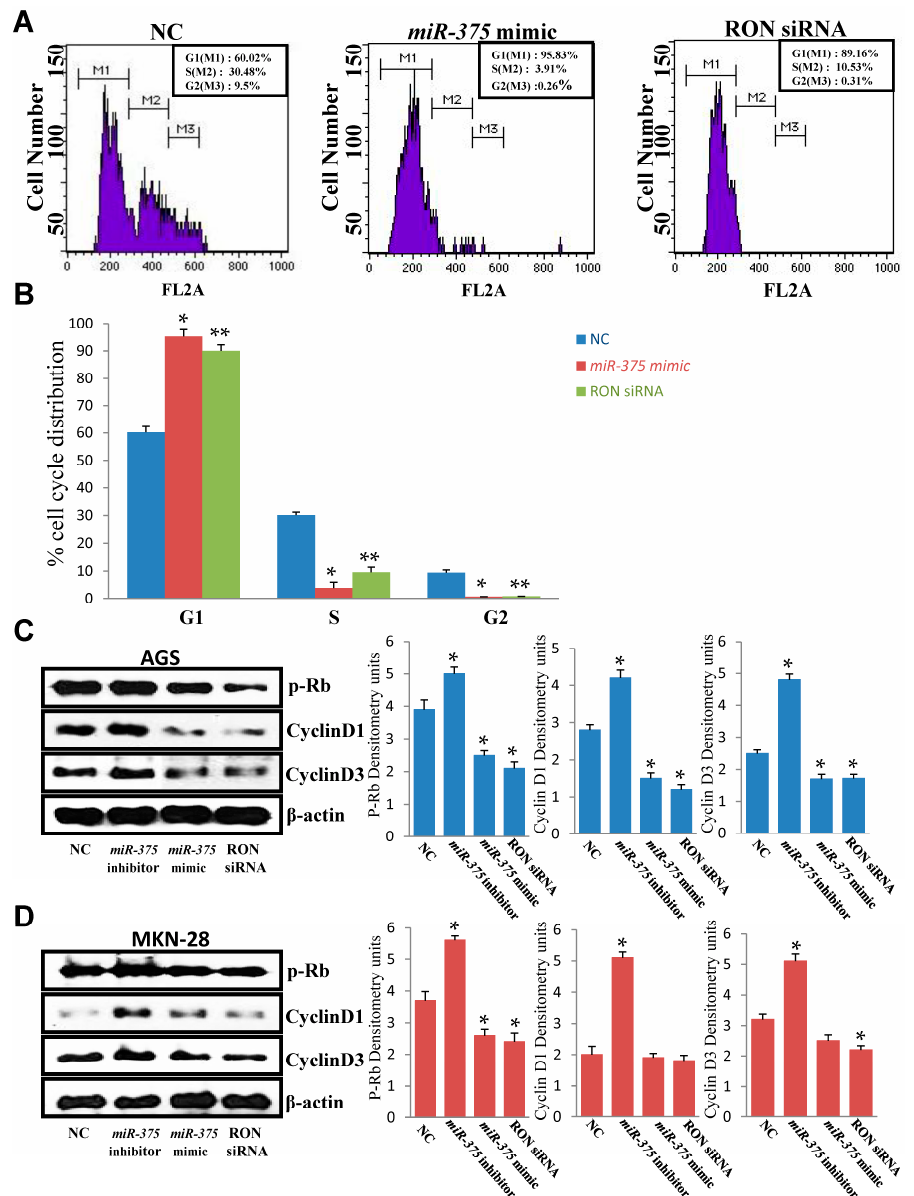
Figure 4. miR-375 and RON regulate the cell cycle by decreasing cyclin D1 and cyclin D3 expression and retinoblastoma (Rb) phosphorylation in AGS and MKN-28 human gastric cancer cells. ( A , B ) Representative histograms show cell cycle distribution of AGS cells in the negative control, miR-375 mimic, and RON siRNA groups. * p < 0.05 versus negative control ( miR-375 mimic); ** p < 0.05 versus negative control (RON siRNA); ( C ) Cyclin D1, cyclin D3, and phosphorylation of Rb were assessed by Western blot analysis 48 h after transfection with a miR-375 mimic, a miR-375 inhibitor, a negative control, or RON siRNA in AGS cells. * p < 0.05 versus negative control; The data represent the mean ± SD from triplicate measurements; ( D ) Cyclin D1, cyclin D3, and phosphorylation of Rb were assessed by Western blot analysis 48 h after transfection with a miR-375 mimic, a miR-375 inhibitor, a negative control, or RON siRNA in MKN-28 cells. * p < 0.05 versus negative control; The data represent the mean ± SD from triplicate measurements.